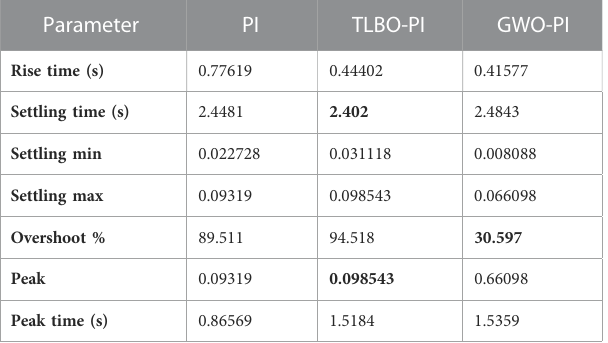
TABLE 2 Comparative study of waveform properties while using PI, TLBO-PI, and GWO-PI.